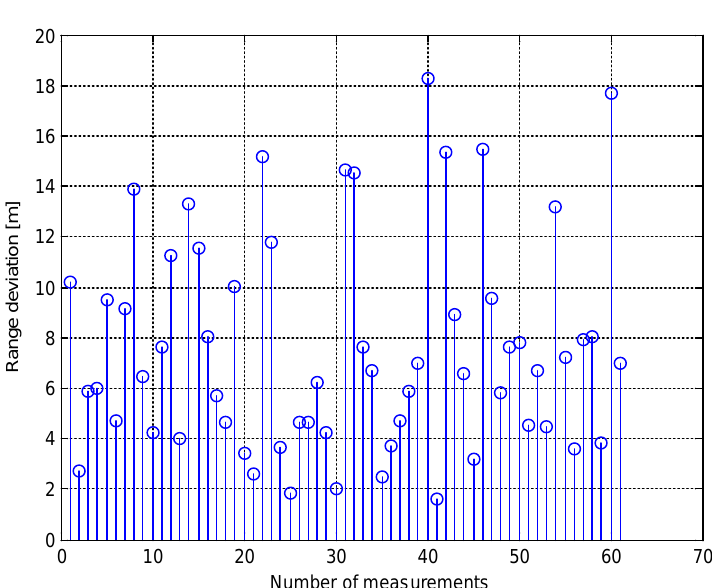
Figure 5. The range deviation of the target (simulation 1).